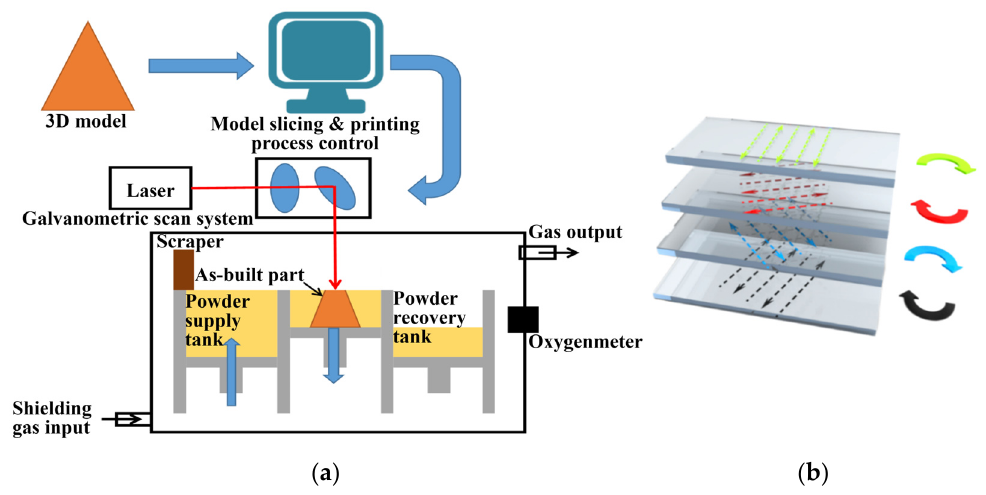
Figure 1. Schematic diagrams of SLM device ( a ) and laser scanning strategy ( b ).